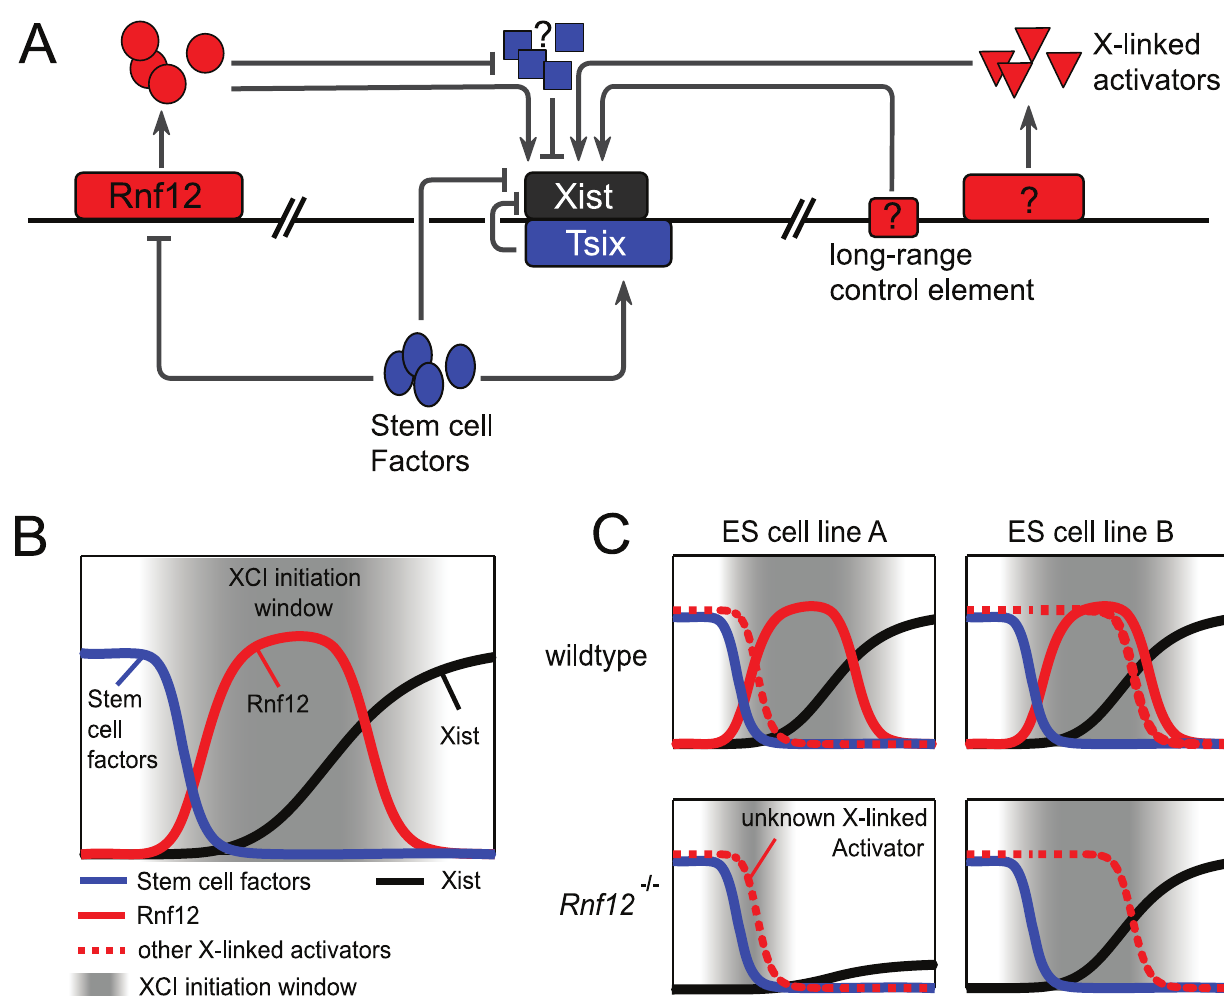
Figure 1. The X chromosome inactivation network. (A) Xist expression is controlled by counteracting activators (red) and repressors (blue). Stem cell factors (blue ovals) might repress Xist directly or indirectly via activating the repressive transcript Tsix or repressing the activator Rnf12. Rnf12 is the only known activator, and may function by targeting the Xist promoter directly and/or by inducing degradation of an unknown Xist repressor (blue squares). The existence of additional X-linked activators (red triangles) and long-range control elements such as Xpr , Xce , Xite , and others (red box) has been suggested [10]. (B) The time window when XCI can be initiated (grey) could be controlled by the down-regulation of Xist repressors such as stem cell factors (blue) and up-regulation of Xist activators like Rnf12 (red). (C) Different cell lines might require Rnf12 (ESC line B) or not (ESC line A), depending on the expression kinetics of other X-linked activators (dotted red line).